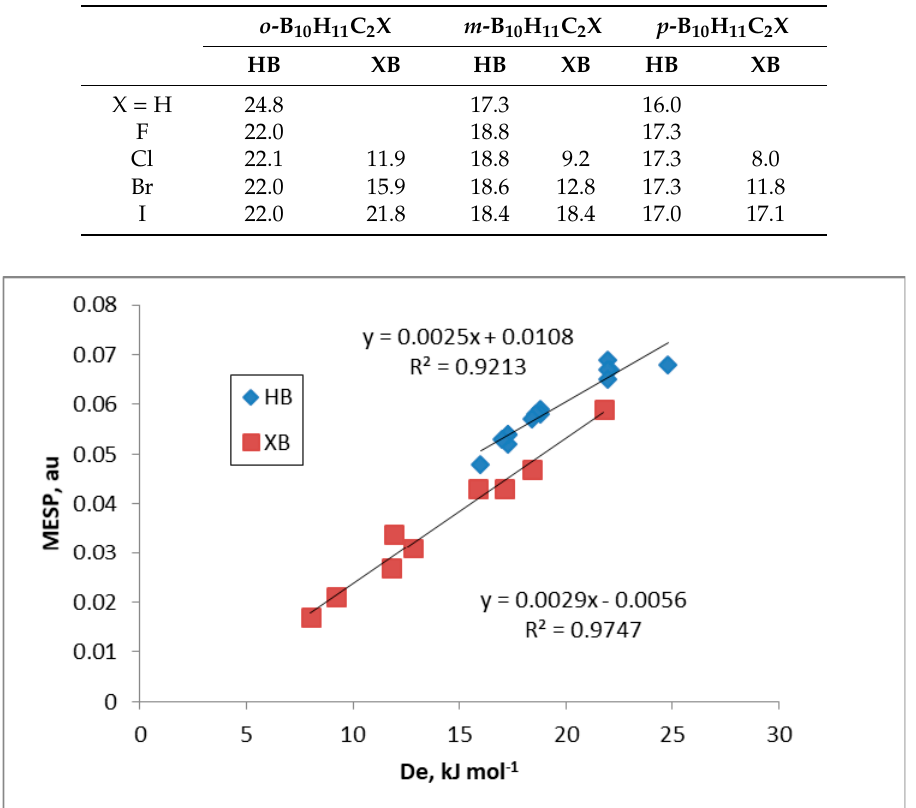
Table 2. Dissociation energy (kJ · mol − 1 ) for the hydrogen- (HB) and halogen-bonded (XB) complexes with NCH.